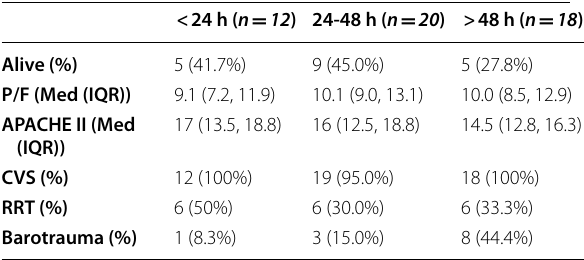
Table 2—Outcome of non-invasive respiratory support failure based on time of